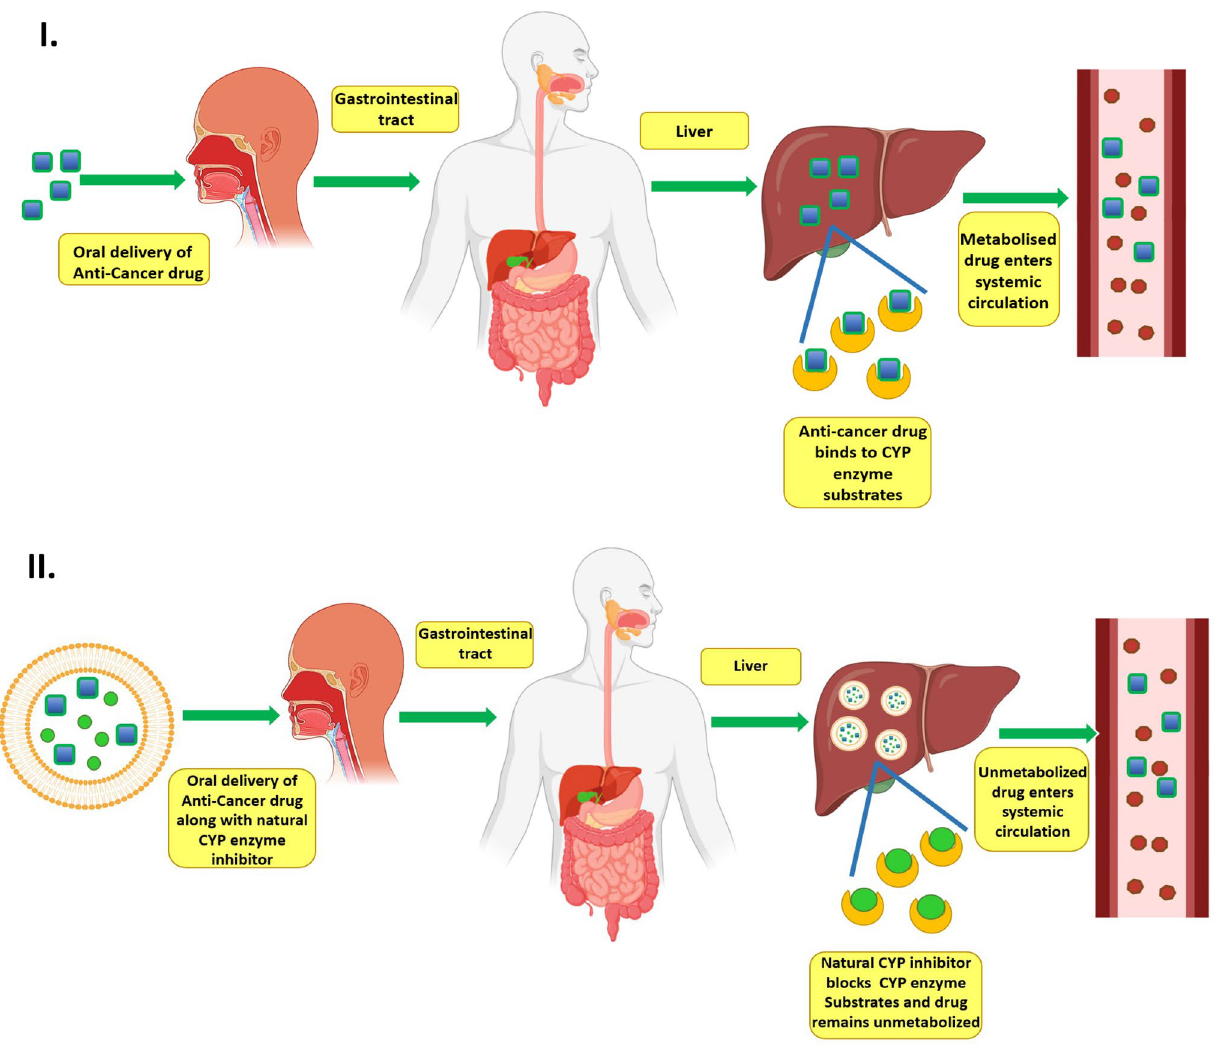
Fig. 1 I Fate of the anti-cancer drug in the body in the absence of a natural cytochrome inhibitor when administered on its own leads to biotransformation of the drug. II Fate of the drug when administered in the form of a novel drug delivery system along with the natural CYP inhibitor inhibitor leads to better systemic absorption of the drug in its unchanged